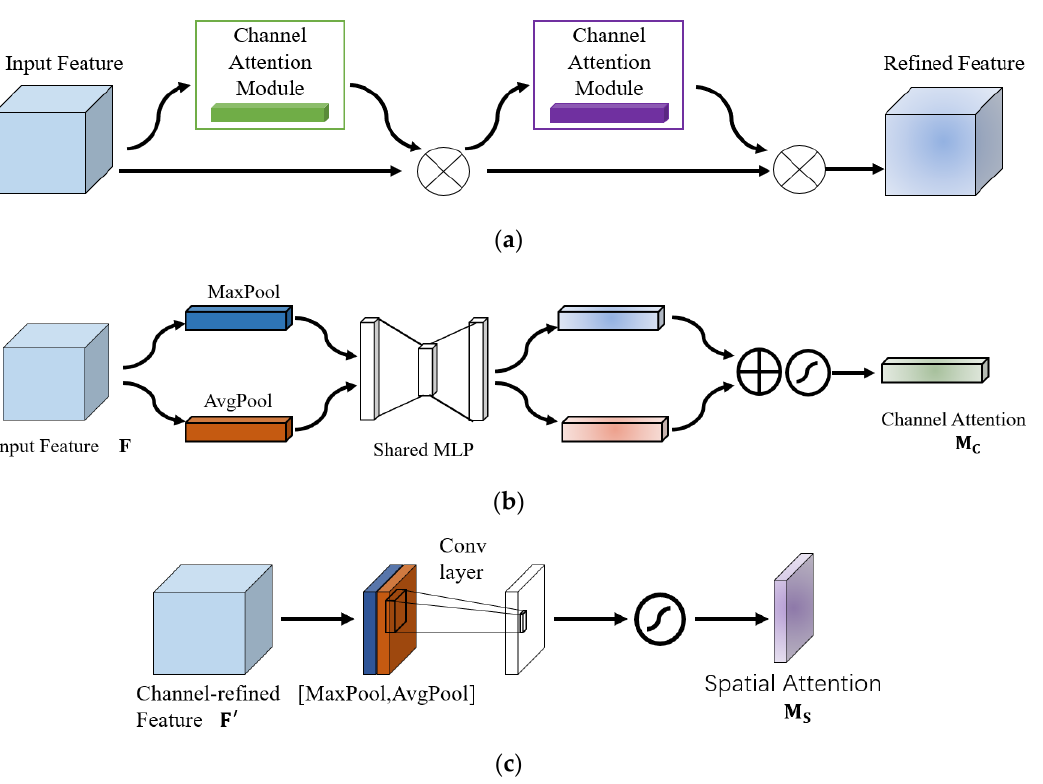
Figure 4. CBAM and internal structure: ( a ) CBAM module structure; ( b ) channel attention structure; ( c ) spatial attention structure.